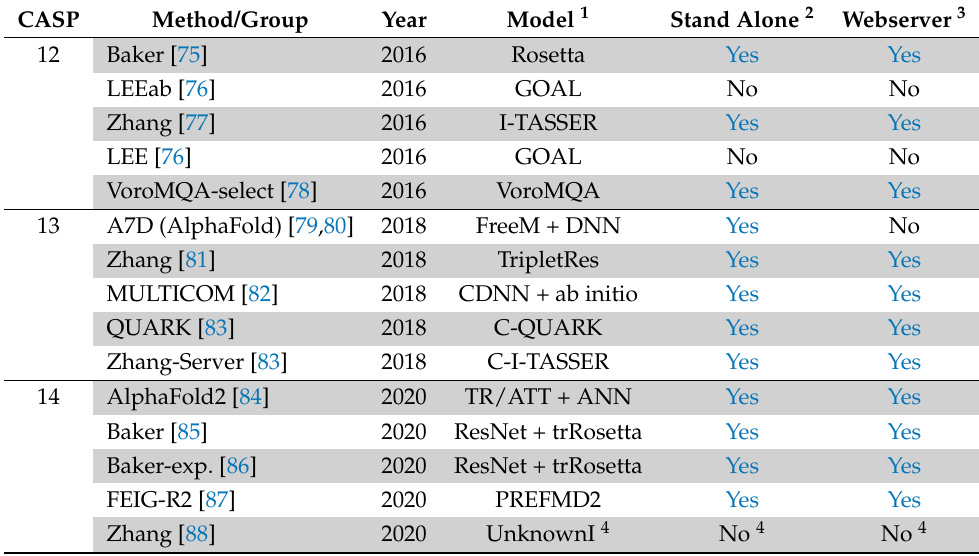
Table 2. Top ML methods for PSP in the regular targets category from CASP12 to CASP14.